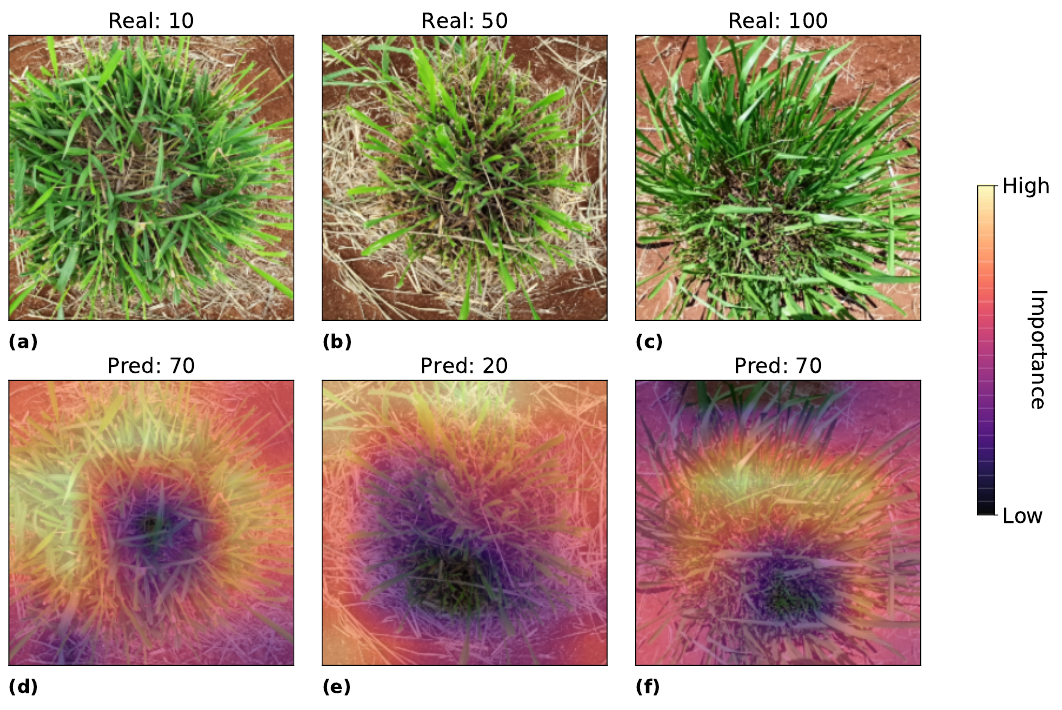
Figure 11. Grad-Cam analysis of the worst predictions. Figures ( a – c ) represents the real image with true score of 10, 50 and 100. Figures ( d – f ) represent the activation maps where the model predicted 70, 20,